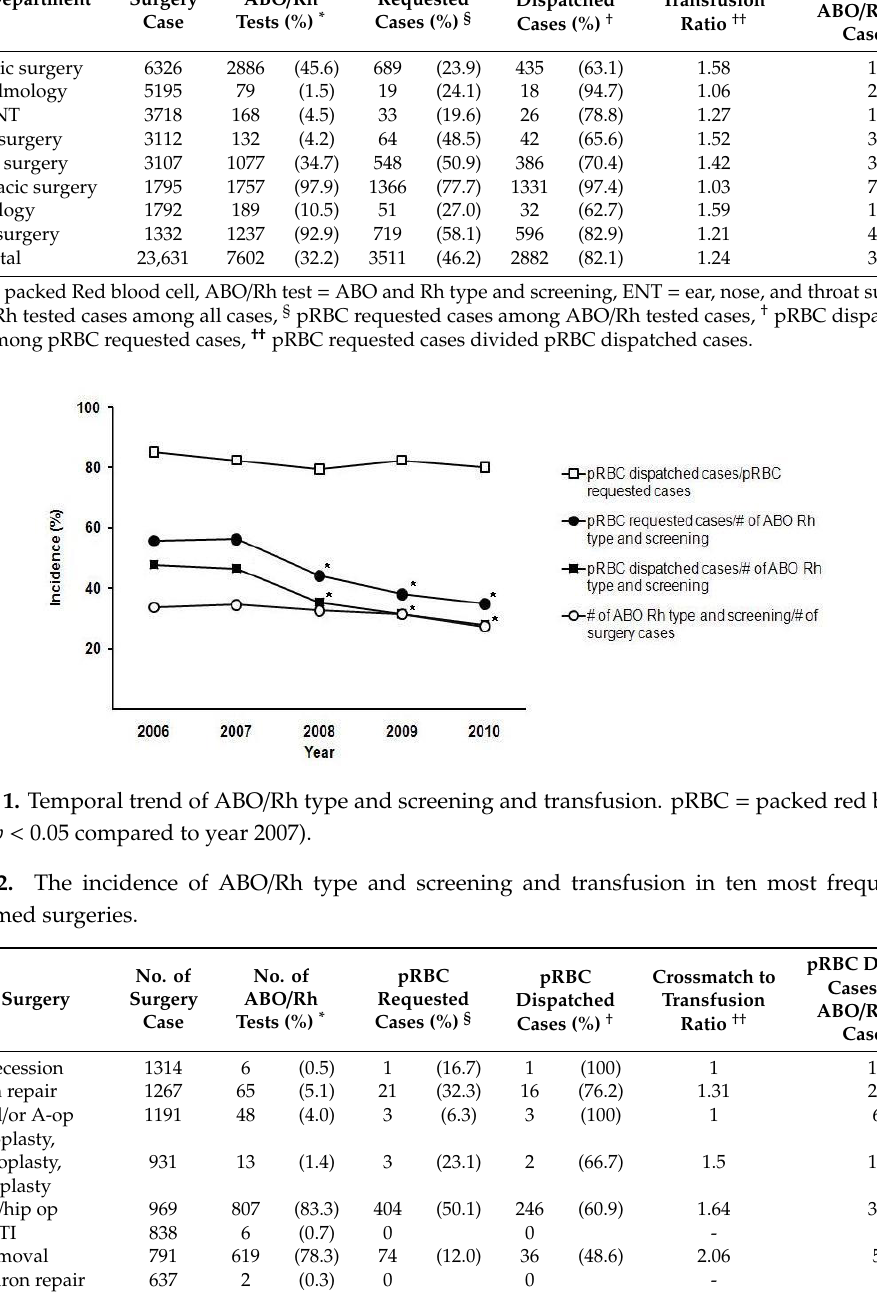
Table 1. Incidence of ABO/Rh type and screening and transfusion.